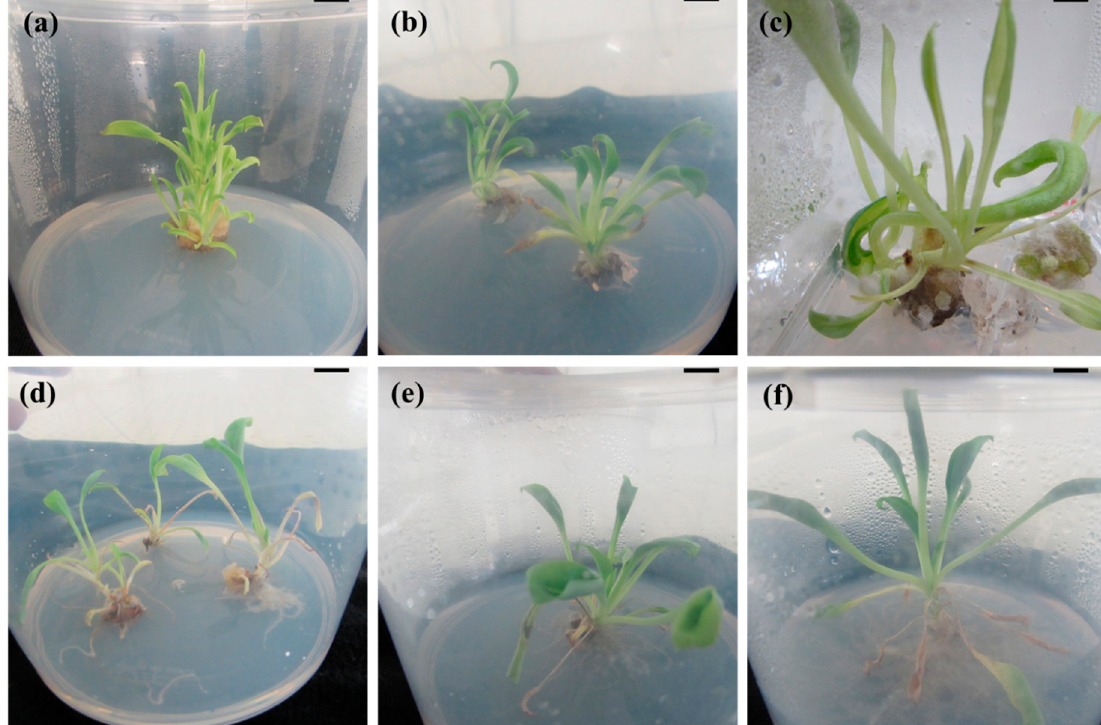
Figure 1. In vitro propagation of Mertensia maritima . Multiple shoot induction from node ( a ) and shoot tip ( b ) explants grown on Murashige and Skoog (MS) medium with 4 µM thidiazuron (TDZ) and 1 µM α -naphthaleneacetic acid (NAA); ( c ) hyperhydric shoots of M. maritima on MS medium with 12 µM TDZ and 2 µM NAA; ( d ) rooting on half-strength MS medium supplemented with 12 µM indole-3-butyric acid (IBA); rooting on half-strength MS medium supplemented with 4 µM IBA after ( e ) four weeks and ( f ) 8 weeks of culture. Scale bar: 2 cm.